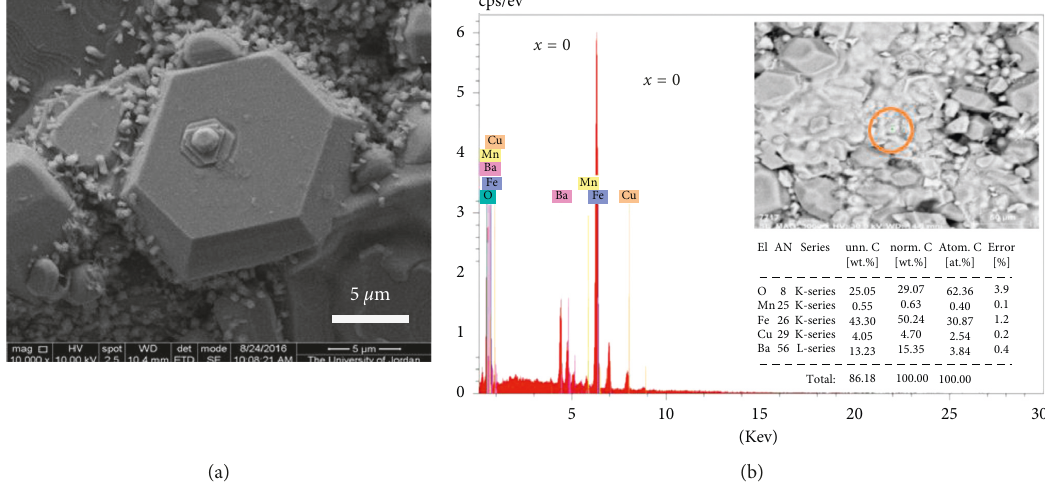
Figure 2: (a) SEM image and (b) EDX measurement for the Ba Table 2: Atomic concentrations and atomic ratios of the different elements in the sample Ba Element light particles Concentration (C)%